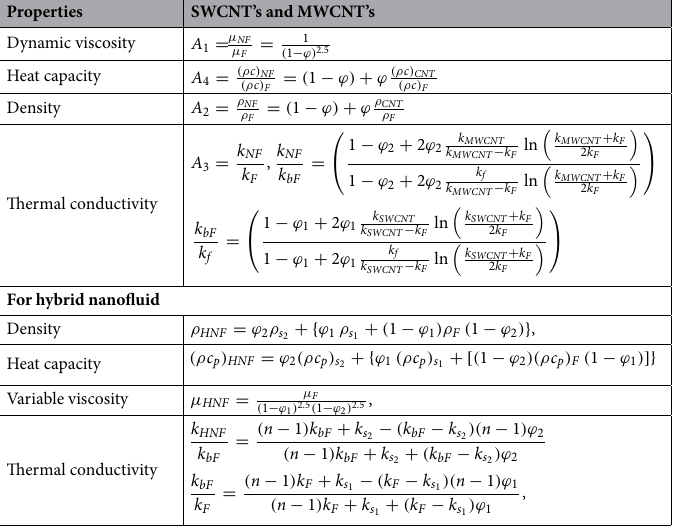
Table 2. The thermophysical characteristics of CNTs are given.